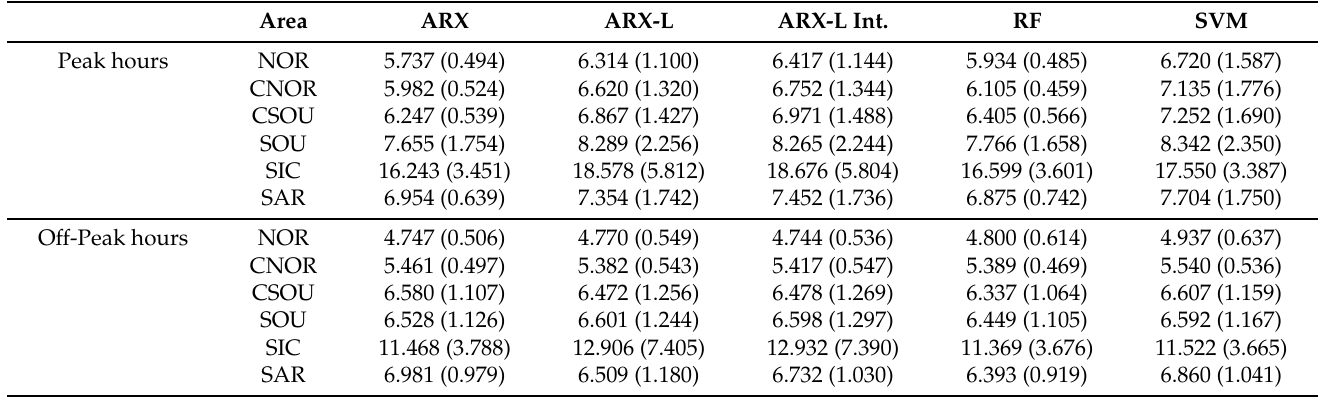
Table A6. Mean value of MAE over peak (14 h) and off-peak (10 h) hours. In parenthesis the standard deviation. The lags of the dependent variable have been